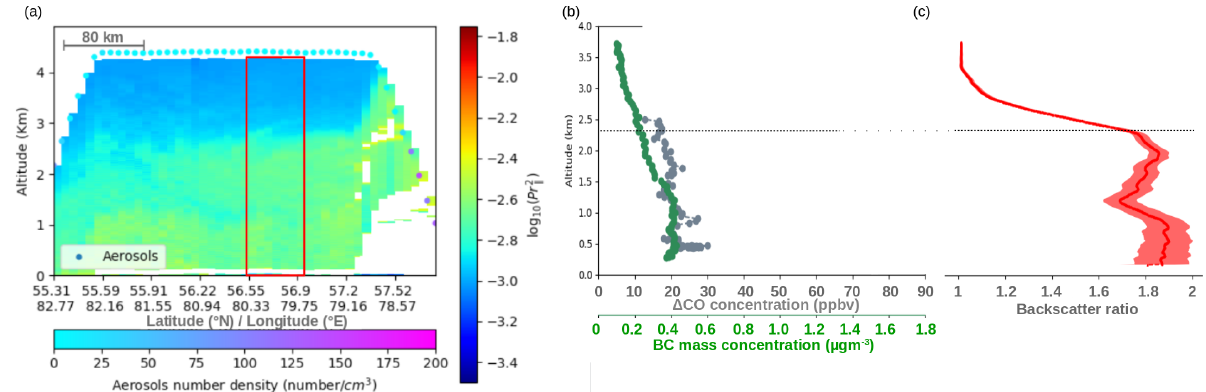
( PR 2 ) on 16 June 2017 at 5 UT. Calibration constant is 13,458 ± 2%. Figure 3. ( a ) Vertical cross-section of airborne lidar log 10 Grimm aerosol concentrations in particle.cm − 3 are shown at the aircraft altitude. ( b ) Vertical profiles of ∆ CO in ppbv (grey), BC in µ g.m − 3 (green) for the descent at 57.5 ◦ N. ( c ) Backscatter ratio vertical profile for the lidar data in the red box. The horizontal dotted line is the top of the aerosol layer according to the lidar data.